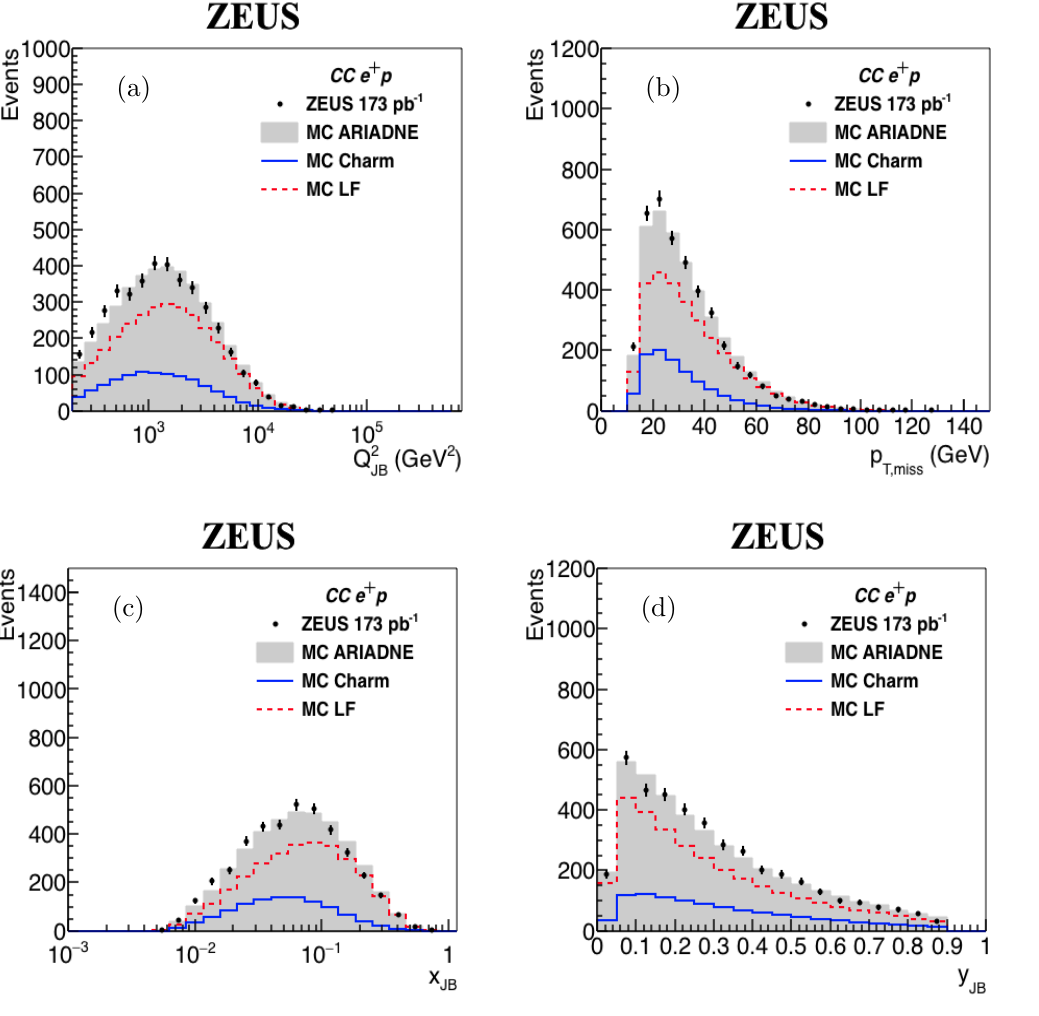
Figure 3. Comparison between data (dots) and MC (histogram) in kinematic variables (a) Q 2 (b) p T; miss , (c) x JB and (d) y JB for e + p collisions. The vertical error bars represent the